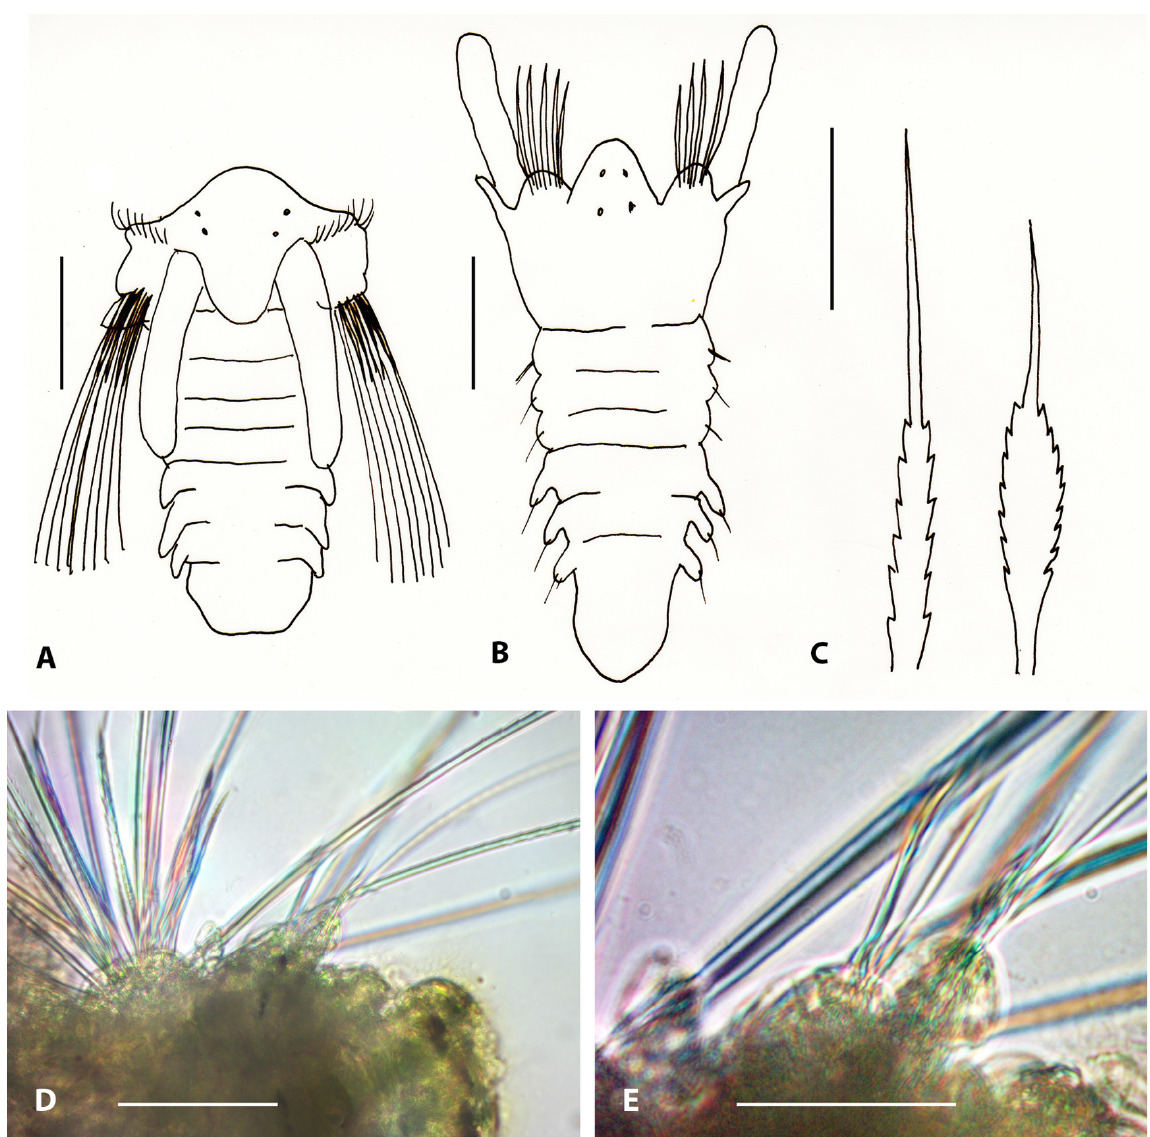
Fig. 7. – Sabellaria spinulosa. A, 30-day larval (benthic) stage (scale bar 100 m m); B, recently metamorphosed specimen (scale bar 100 m m); C, settling paleae from metamorphosed specimen (scale bar 20 m m); D, settling paleae within provisional chaetae (scale bar 100 m m); E, chaetae from a parathoracic segment (scale bar 50 m m).